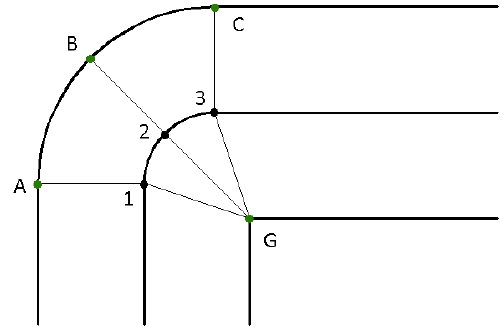
Figure 17. The banks and the cross-sections after removal of the closed loop.